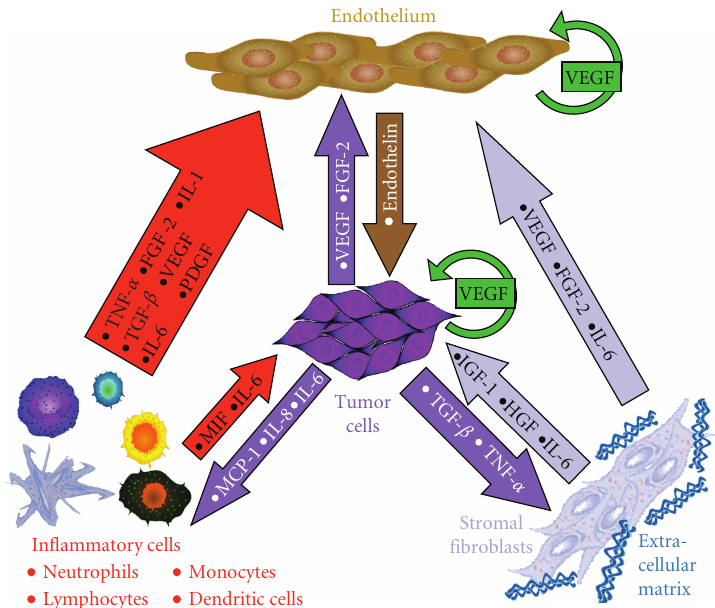
Figure 2: Tumor-associated angiogenesis is sustained through stromal microenvironment crosstalk. Most tumors are associated with the activation of tumor-promoting innate immune responses involving neutrophils, macrophages, and NK cells. Specific (adaptive) antitumor immune responses involving T- or B-lymphocytes are less e ffi cient in suppressing tumor growth. Increased formation of blood and lymphatic vessels in bone marrow and lymph nodes provide oxygen and nutrients to malignant cells. Stromal cells, including ECs, inflammatory cells, and fibroblasts/myofibroblasts, produce cytokines and growth factors that act in a paracrine fashion to promote malignant cell proliferation or survival. In turn, malignant cells produce angiogenic factors and express their cognate receptors establishing functional autocrine loops to perpetuate their survival including signaling through the VEGF pathway [85–87, 107]. The secreted factors produced by and in response to those secreted by stromal and tumor cells include, but are not limited to VEGF, FGF-2, PDGF, IGF-1, HSF, TGF- α , TGF- β , TNF- α , IL- 8, MCP-1/CCL2, MIF, IL-6, and IL-1 [95]. The potent vasoconstrictor peptide endothelin-1 has been implicated in the pathophysiology of atherosclerosis and its complications [108], as well as tumor angiogenesis and lymphangiogenesis [109, 110]. Proteases important for invasion thorough the basement membrane and remodeling of the ECM, such as plasminogen [96] and MMPs, including MMP-2 and MMP-9 [97], and their inhibitors, PAI-1/2 and TIMPs, respectively, are produced by stromal and tumor cells. Downregulation of endogenous inhibitors of angiogenesis such as thrombospondin (TSP)-1 occurs in the stromal compartment as well to favor angiogenesis, cancer cell growth, and metastasis [98]. In recent years, it has been recognized that a better understanding of the tumor-stromal microenvironment crosstalk may lead to elucidation of new therapeutic strategies for cancer therapy